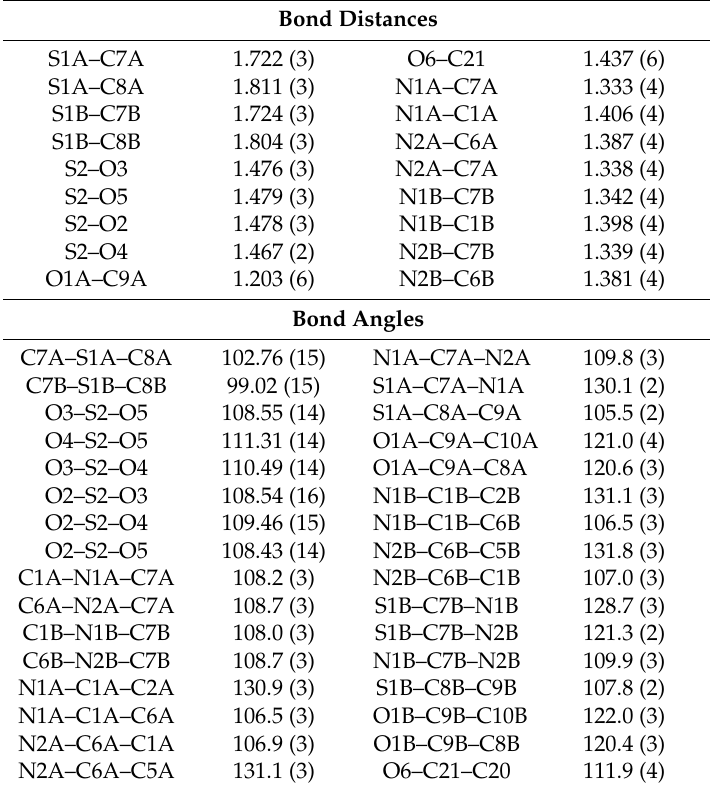
Table 2. Selected geometric parameters (Å, ˝ ) for compound 4u